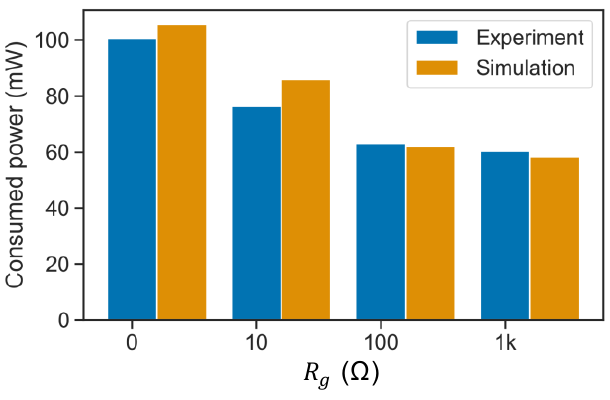
Figure 11. Power consumption with different 𝑅 𝑔 .